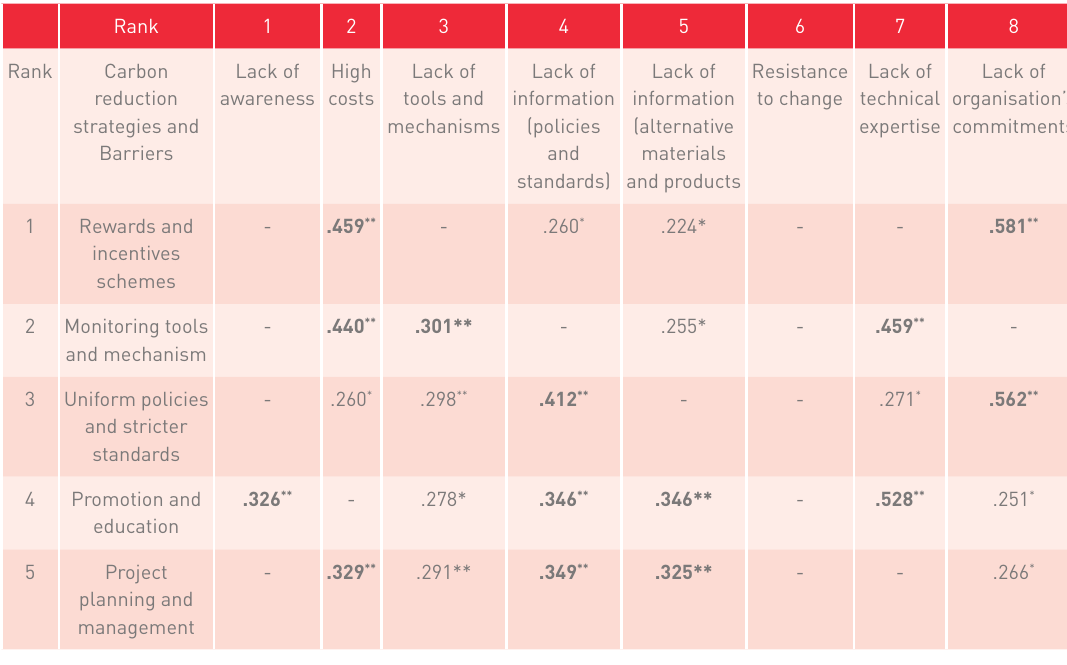
A consolidation of the descriptive statistics based on mean ranking and inter-correlations between the carbon reduction strategies and the barriers (constructs)